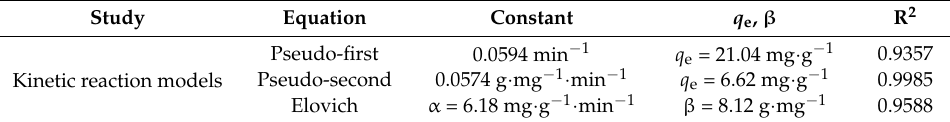
Table 3. Kinetic parameters for Cu 2+ adsorption onto